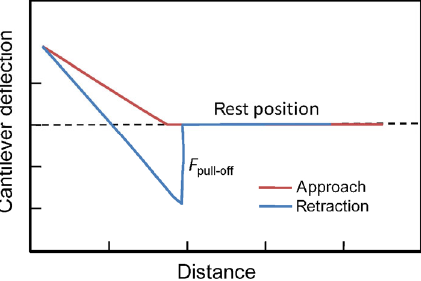
Fig. 3 Schematic representation of an AFM force-displacement curve showing the typical behavior of cantilever at tip-sample interaction.